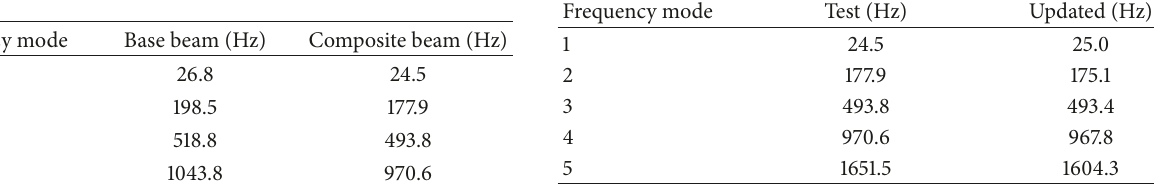
Table 2: Experimental natural frequencies of the base beam and the composite beam.